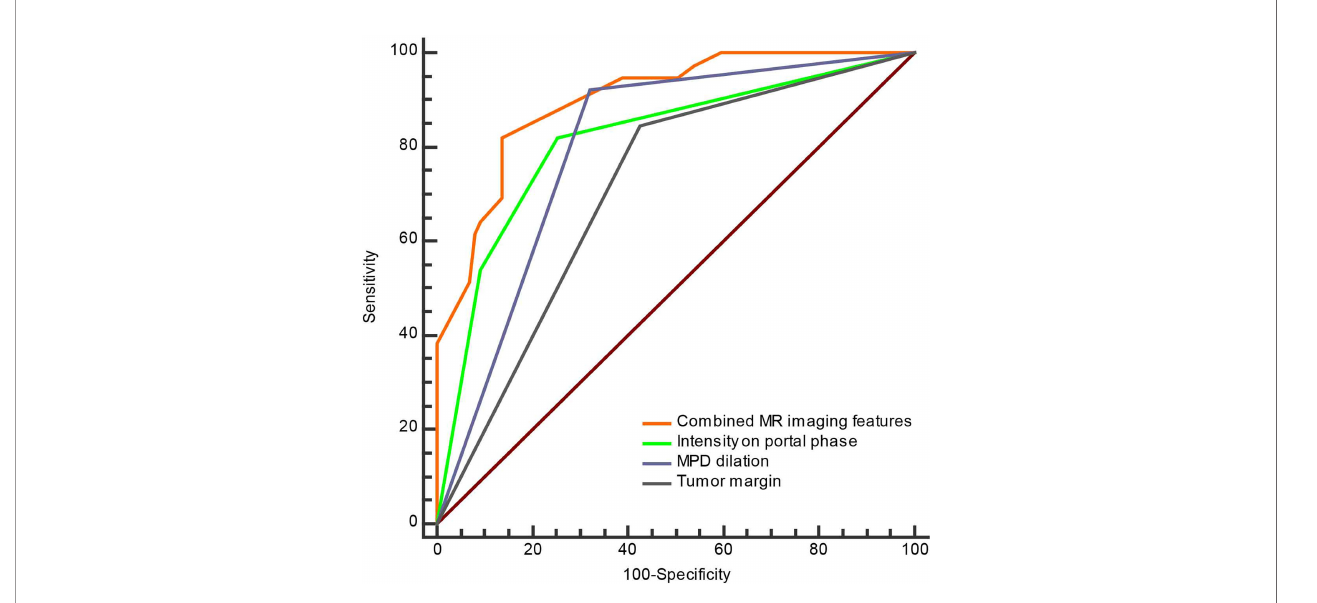
FIGURE 3 | The ROC curve of separate three MRI features and combined MRI features for discrimination of the non-hypervascular PNETs from